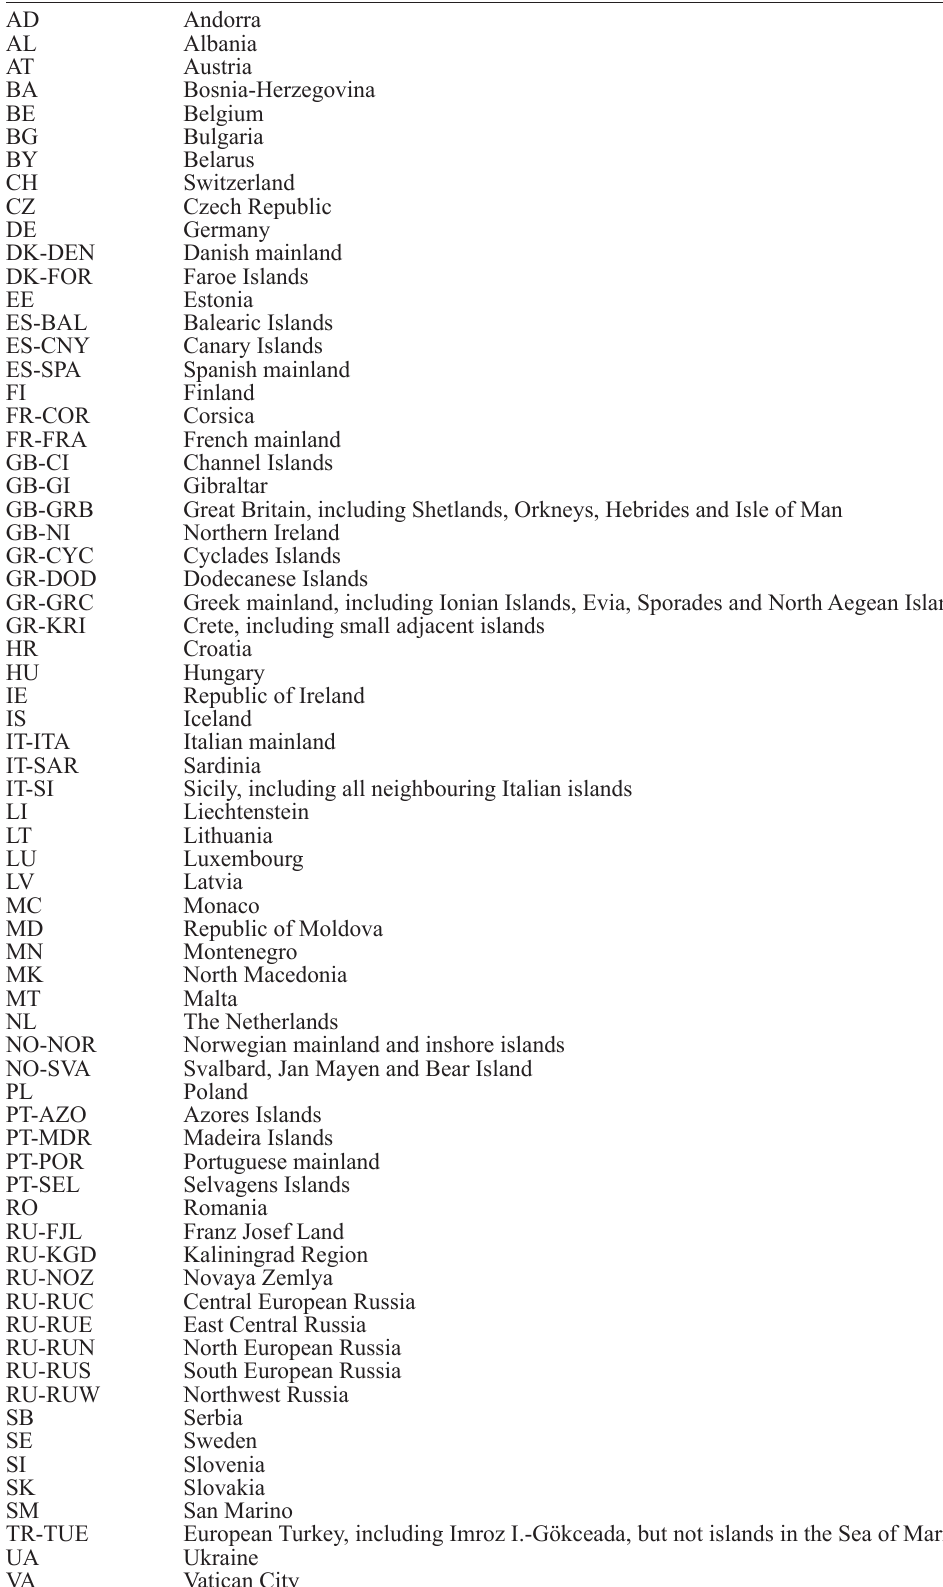
Table 3. Geopolitical units in Europe as used in the present atlas and in Fauna Europaea .